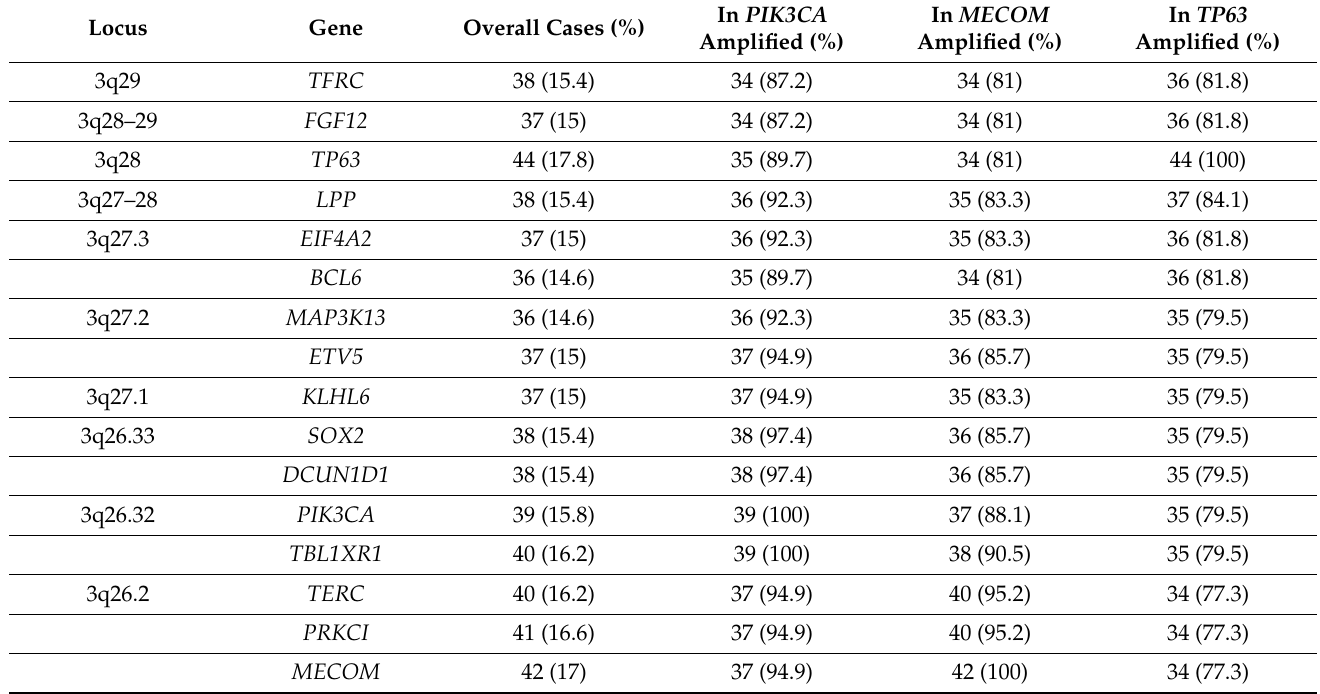
Table 1. Amplified genes from loci 3q26.2 to 3q29 listed in OncoKB in TCGA cervical squamous cell carcinoma cohort ( n = 247) and in subsets with PIK3CA ( n = 39). The subset of cervical squamous cell carcinomas with MECOM ( n = 42) and TP63 amplifications ( n = 44) are also presented as examples of overlap of amplifications in more aminoterminal (3q26.2: MECOM ) and carboxyterminal regions (3q28: TP63 ).